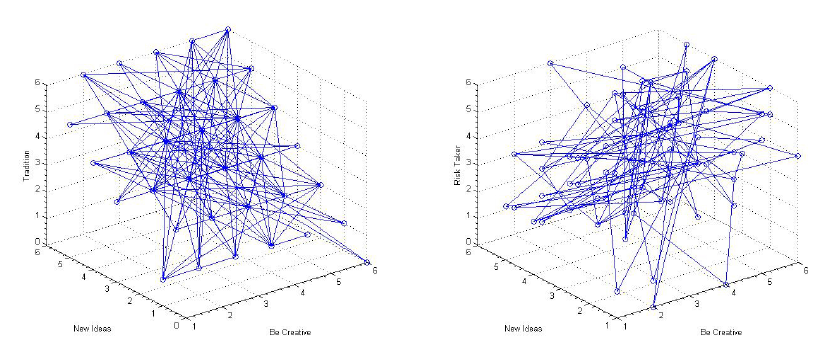
Figure 1. Three dimensions of relationships among new ideas, be creative (subjective creativ- ity) with tradition and risk taking (source: created by authors)